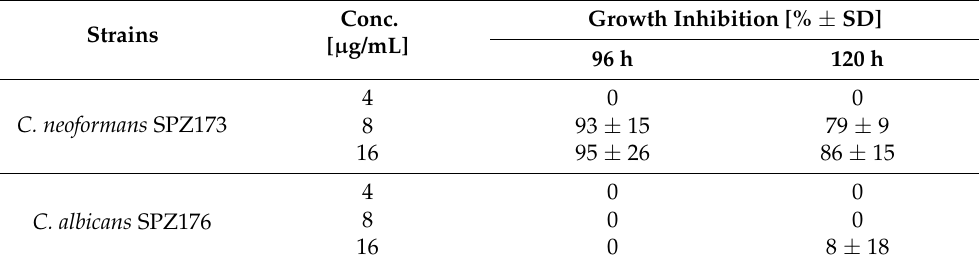
Table 5. Antifungal activity of 5h against the clinical isolates in sorbitol as osmotic protector. Conc. Growth Inhibition [% ± SD] Strains